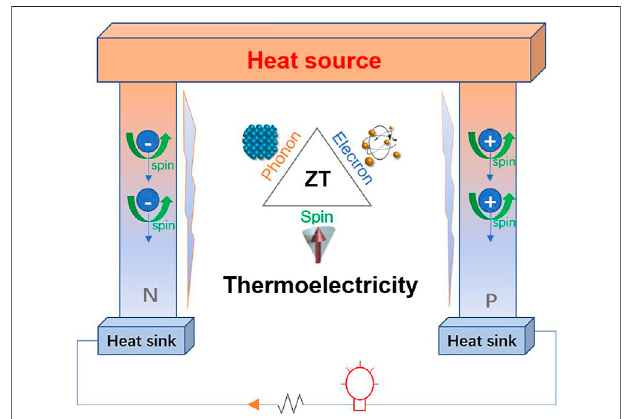
FIGURE 1 | Schematic diagram of